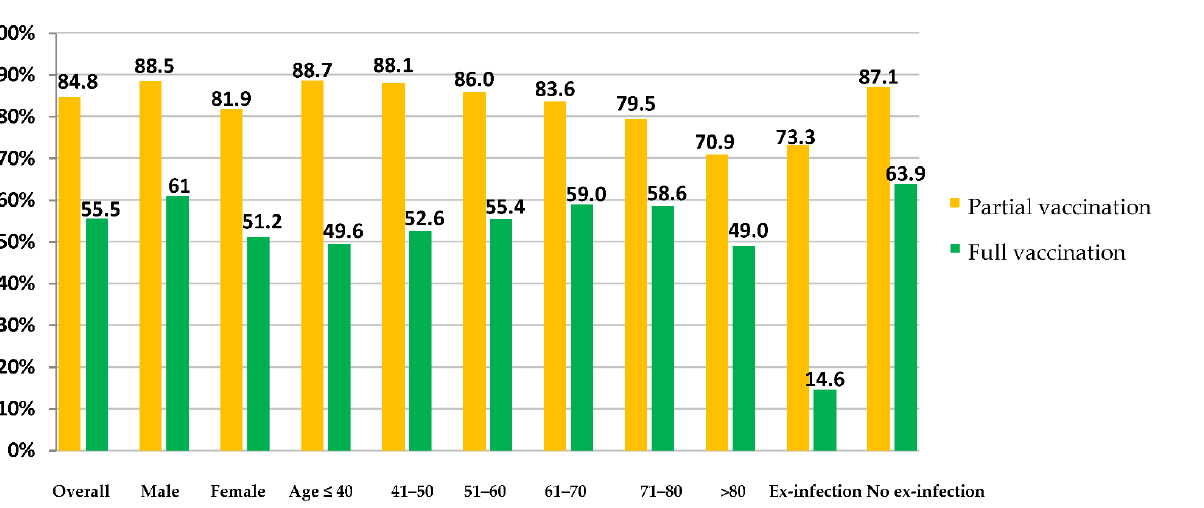
Figure 2. The rates of partial and full vaccination status among patients with type 2 diabetes as of 16 July